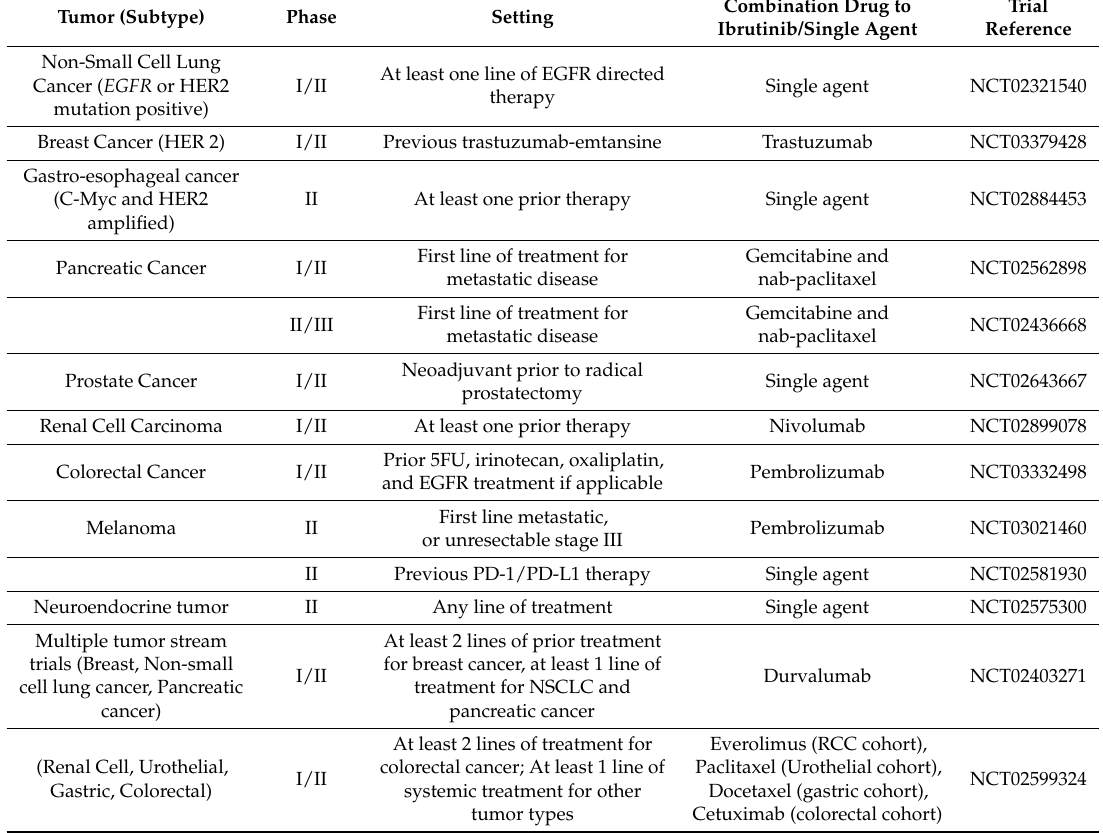
Figure A2. Ibrutinib is a covalent inhibitor of BTK that binds irreversibly to the cysteine 481 residue near the ATP binding pocket of BTK. Table A1. Table of current trials of ibrutinib in non-hematological malignancies.